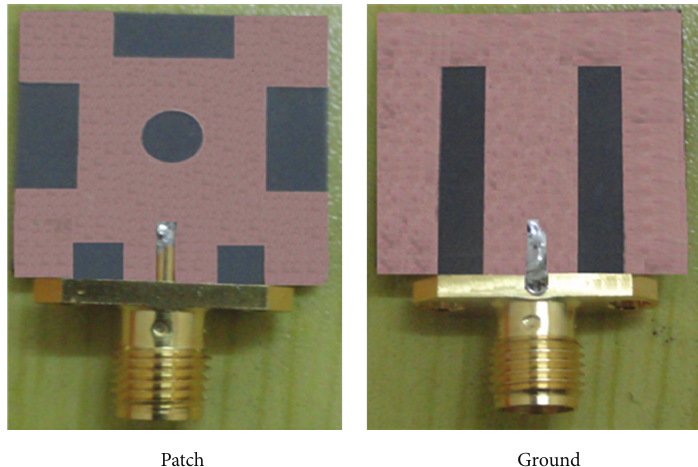
Figure 2: Prototype of the proposed antenna.